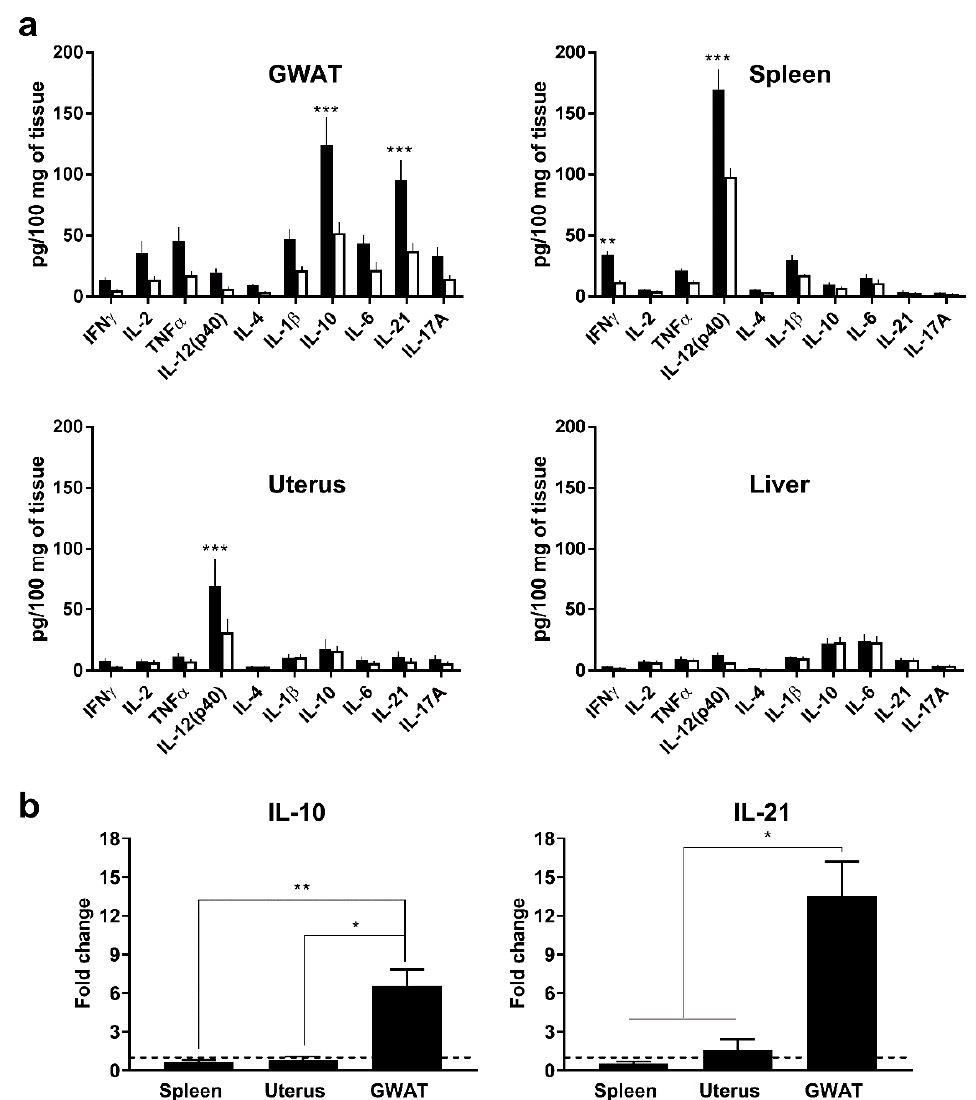
Figure1. Organ-specificcytokineexpressionafterpolyinosinic:polycytidylicacid(poly[I:C])stimulation. Figure 1. Organ-specific cytokine expression after polyinosinic:polycytidylic acid (poly[I:C]) ( a ) Cytokine expression in C57Bl / 6J (black columns) and TLR3 KO (white columns) mouse organs at 12 h stimulation. ( a ) Cytokine expression in C57Bl/6J (black columns) and TLR3 KO (white columns) after intraperitoneal administration of 20 mg / kg of poly(I:C). ( b ) Relative expression of IL-10 and IL-21 mouse organs at 12 h after intraperitoneal administration of 20 mg/kg of poly(I:C). ( b ) Relative in C57Bl / 6J mouse organs (expression was normalized by liver expression of same cytokines (value of expression of IL-10 and IL-21 in C57Bl/6J mouse organs (expression was normalized by liver 1) denoted with a dashed line). Bars represent average values from two independent experiments (total expression of same cytokines (value of 1) denoted with a dashed line). Bars represent average values n = 7). Errors bars denote standard error of the mean (SEM). *, **, and *** denote p values ≤ 0.05, 0.01, from two independent experiments (total n = 7). Errors bars denote standard error of the mean (SEM). and 0.001, respectively, according to Sidak’s multiple comparisons *, **, and *** denote p values ≤ 0.05, 0.01, and 0.001, respectively, according to Sidak’s multiple comparisons test.